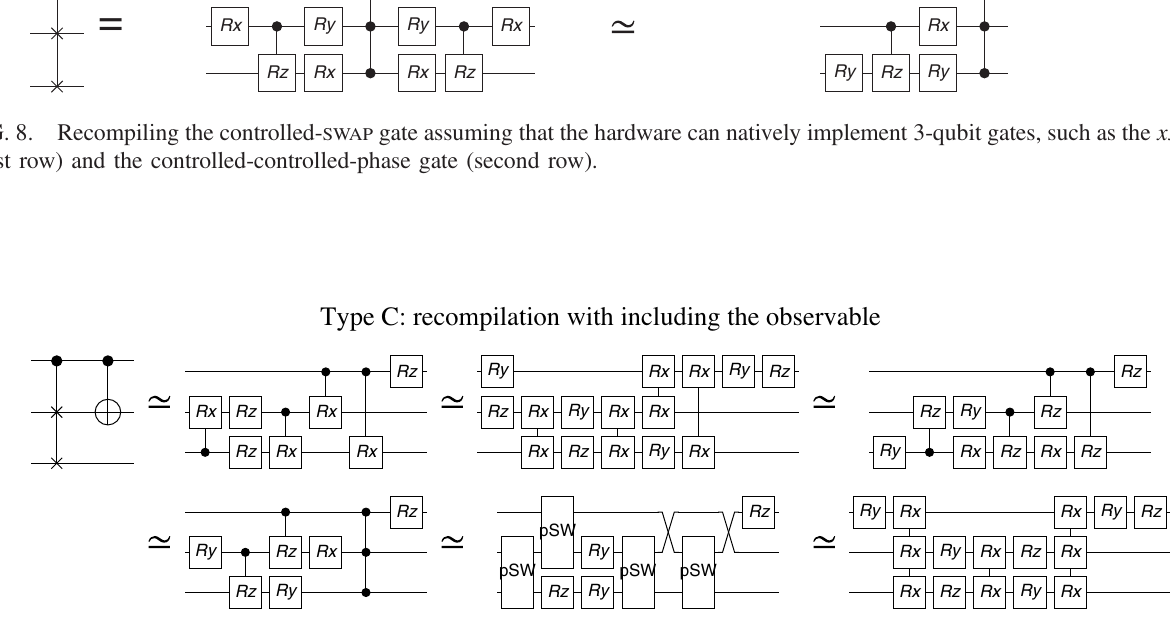
FIG. 9. Type C: recompiling the product of the controlled- SWAP gate and the controlled observable σ up to a local SU(4) freedom on the swapped